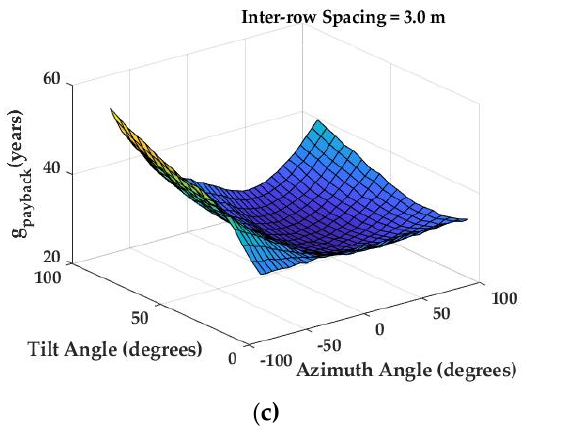
Table 5. Payback time considering incentives for optimum layout of a PV system in the ADMIN, CAM, and EAS